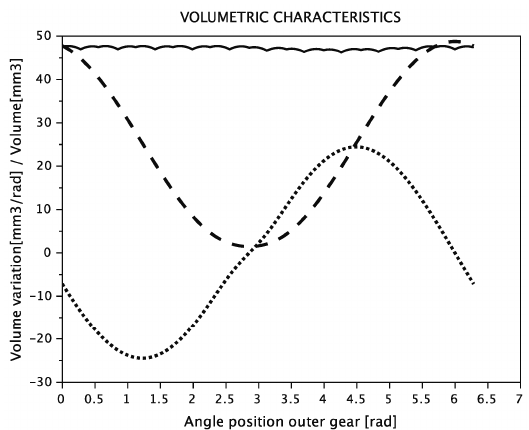
Figure 12. Volumetric characteristics: chamber volume (dash line), volume variation (dot line), and instantaneous flow (solid line) [29].